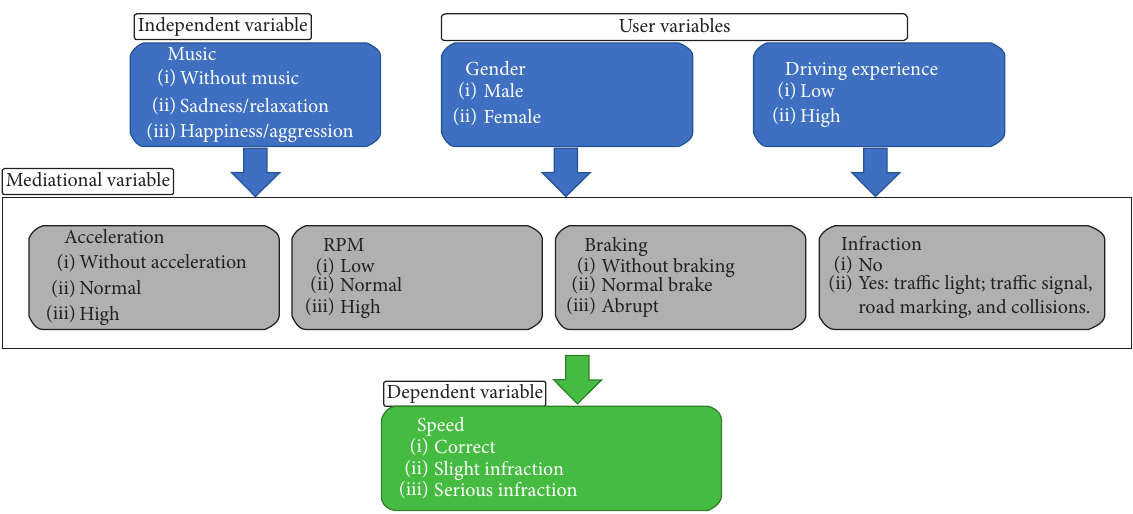
Figure 1: Conceptual